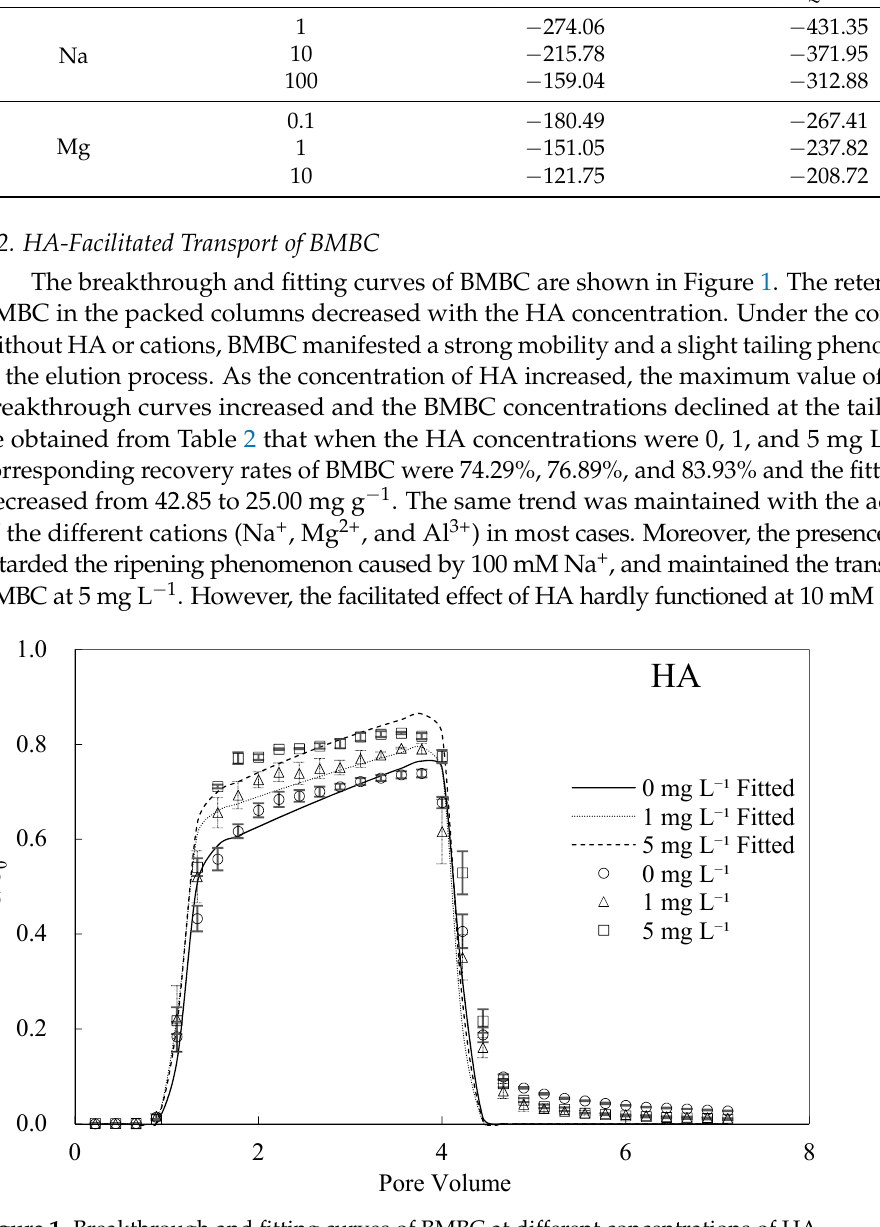
Figure 1. Breakthrough and fitting curves of BMBC at different concentrations of HA. Table 2. Experimental conditions and fitting results for all column experiments.